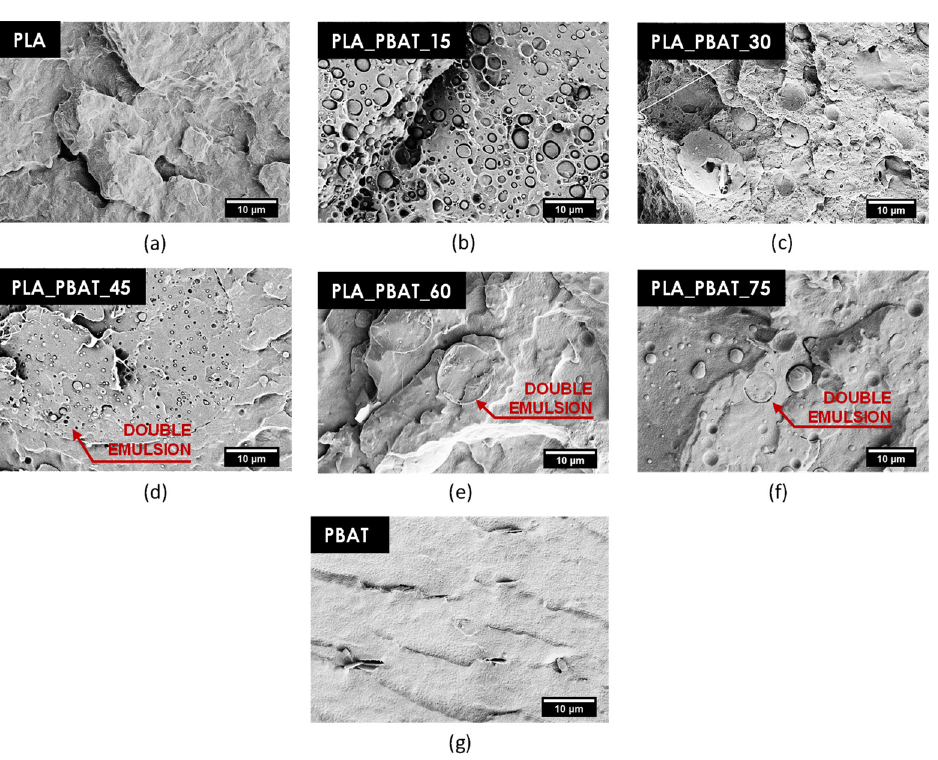
Figure 4. SEM micrographs of the cryofracture surface of neat PLA, neat PBAT and the prepared blends: ( a ) PLA; ( b ) PLA_PBAT_15; ( c ) PLA_PBAT_30; ( d ) PLA_PBAT_45; ( e ) PLA_PBAT_60; ( f ) PLA_PBAT_75; and ( g ) PBAT.